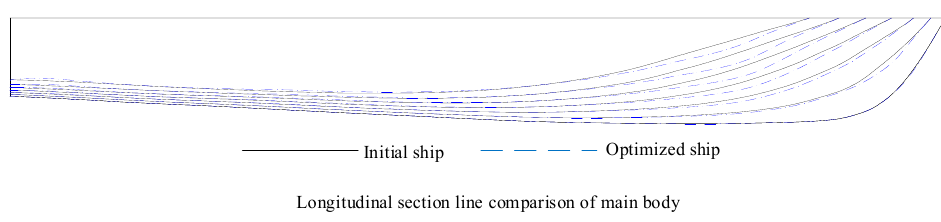
Figure 13. Comparison of main body lines.